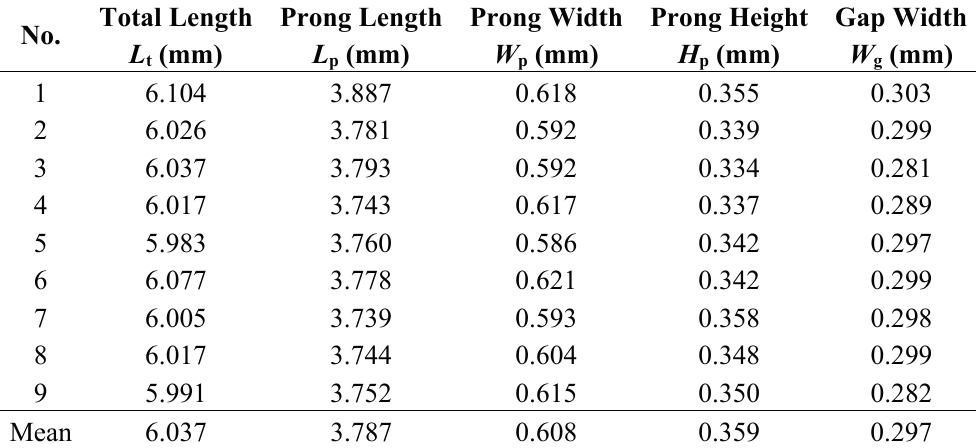
Table 1. Geometric dimensions measurements of nine random tuning forks (TFs).